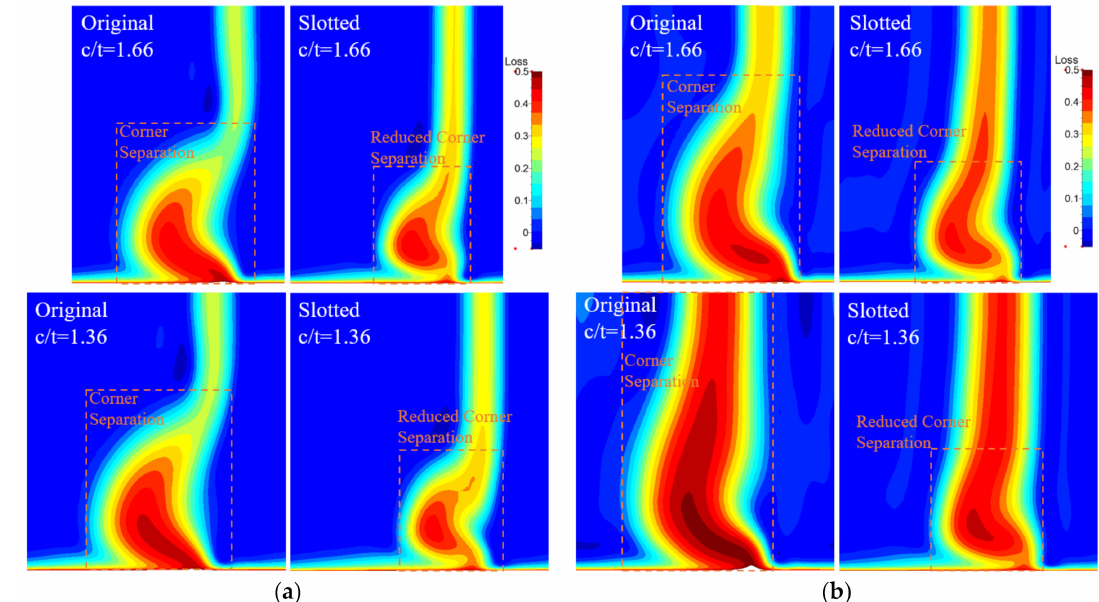
Figure 12. Total pressure loss contours on the planes located 1.0c downstream from the blade TE of the original cascade and combined slotted cascade: ( a ) 0 ◦ ; ( b ) 6 ◦